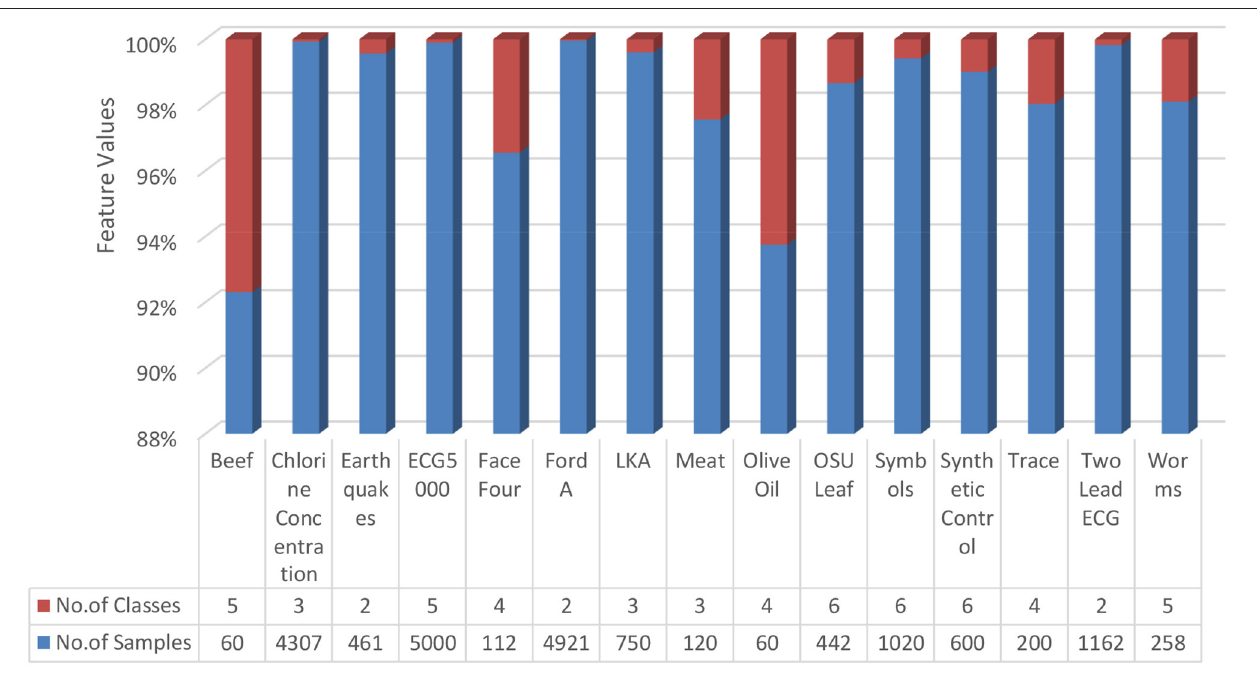
FIGURE 7 | Dataset from UEA and UCR